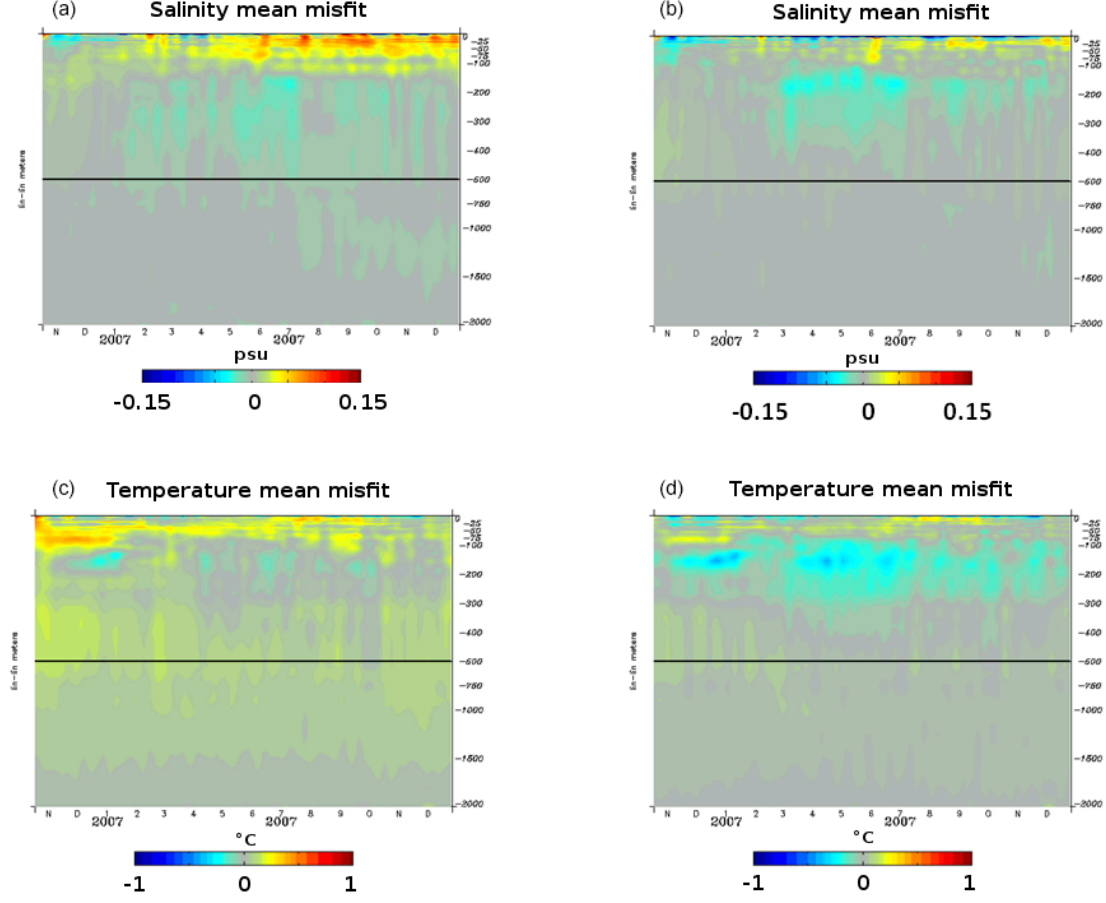
Figure 5. Diagnostics (time series) with respect to the vertical temperature and salinity profiles over the October 2006–December 2007 period. Mean misfit between observations and model for salinity ( a, b , units in psu) and for temperature ( c, d , units in ◦ C) starting from WOA09 climatology (a, c) and robust EN4 (b, d) .